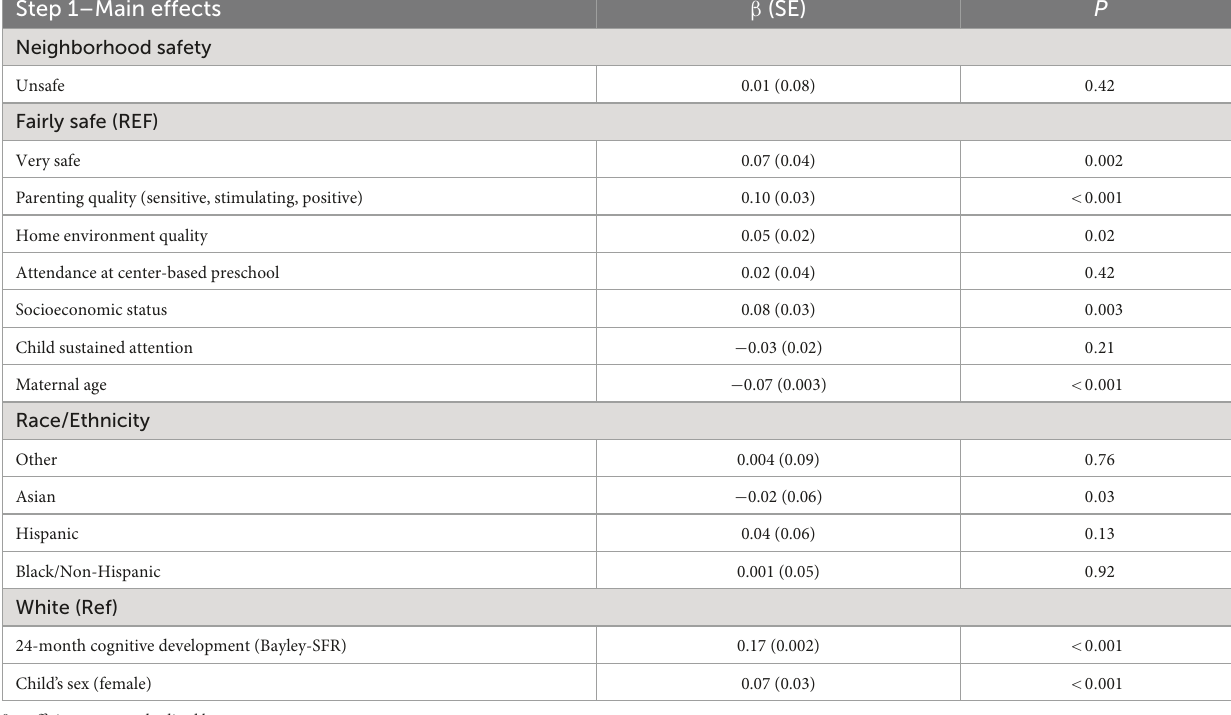
TABLE 3 Adjusted associations of neighborhood safety, parenting quality, home environment, and SES on curiosity (main effects, step 1). Step 1–Main effects